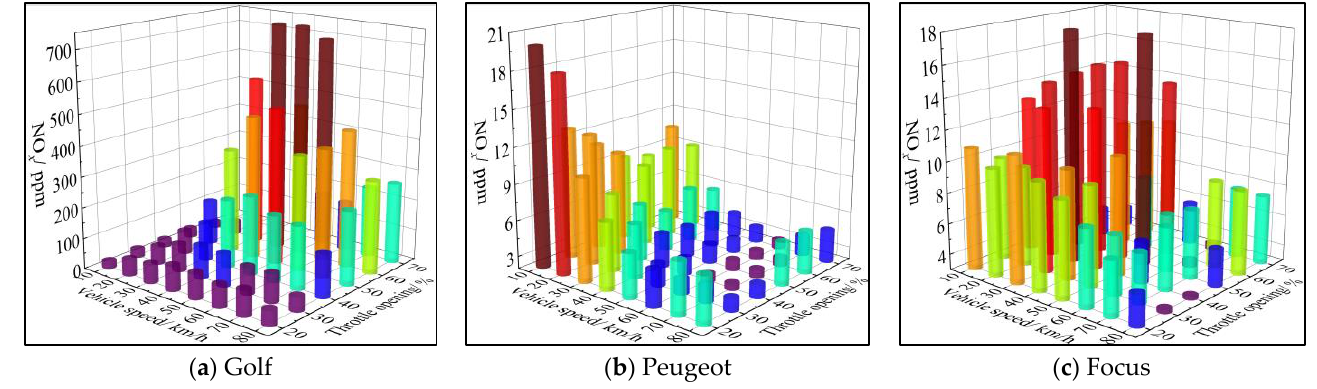
Figure 10. NO x concentration vs. vehicle speed and throttle opening.